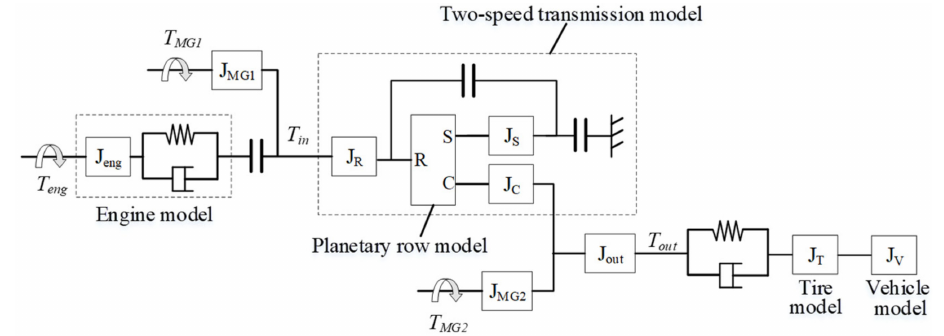
Figure 2. The drivetrain model of the two-speed series-parallel hybrid